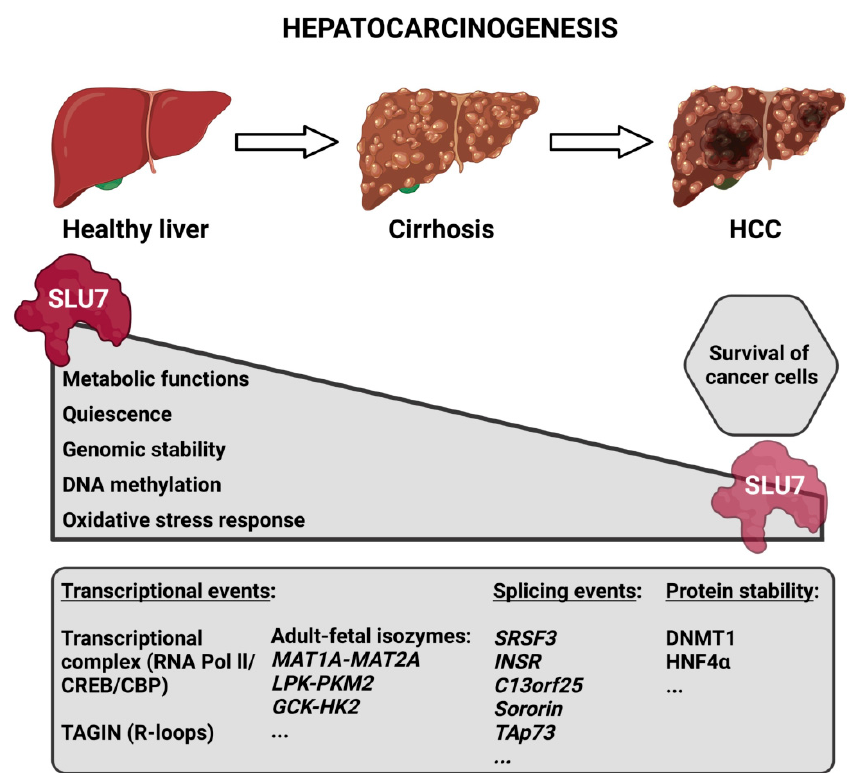
Figure 5. Schematic representation depicting SLU7’s involvement in the process of hepatocarcinogenesis. During the progression of liver disease, the expression of SLU7 decreases in parallel with the alteration of essential cellular functions. However, the residual SLU7 expression in tumoral cells is essential for their survival. The bottom box depicts some SLU7-controlled gene expression events that are altered during liver disease progression. Abbreviations: HCC, hepatocellular carcinoma; TAGIN, transcription-associated genome instability.